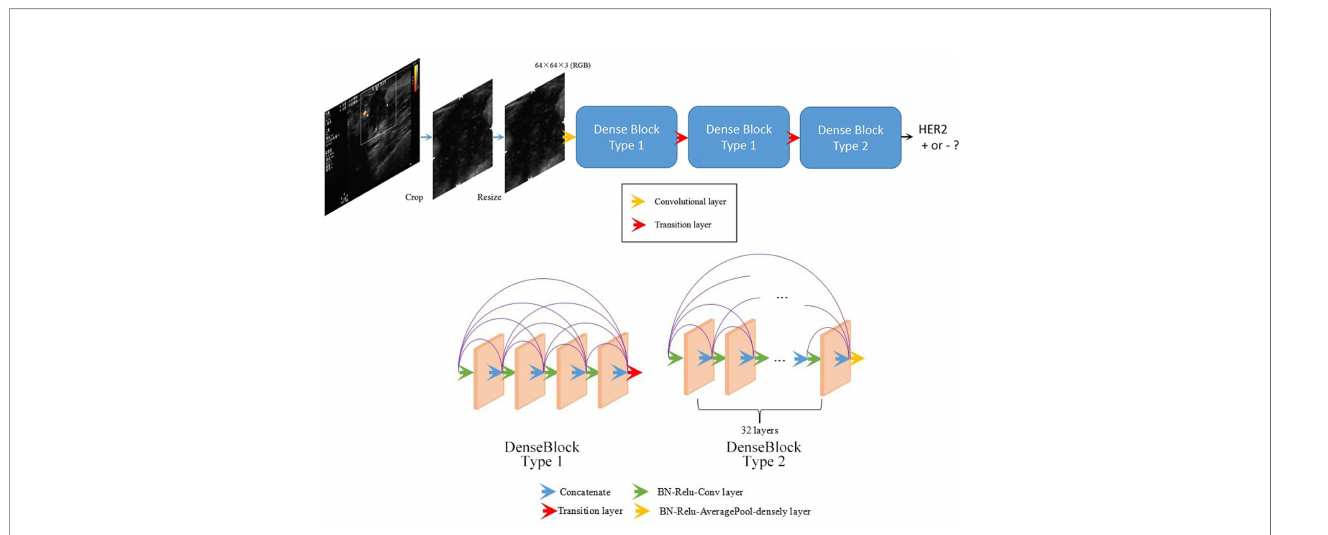
FIGURE 1 | Overall structure of the developed DenseNet-based deep learning classi fi er. Being fed a tumor image, the deep learning model predicts the probability of the expression of